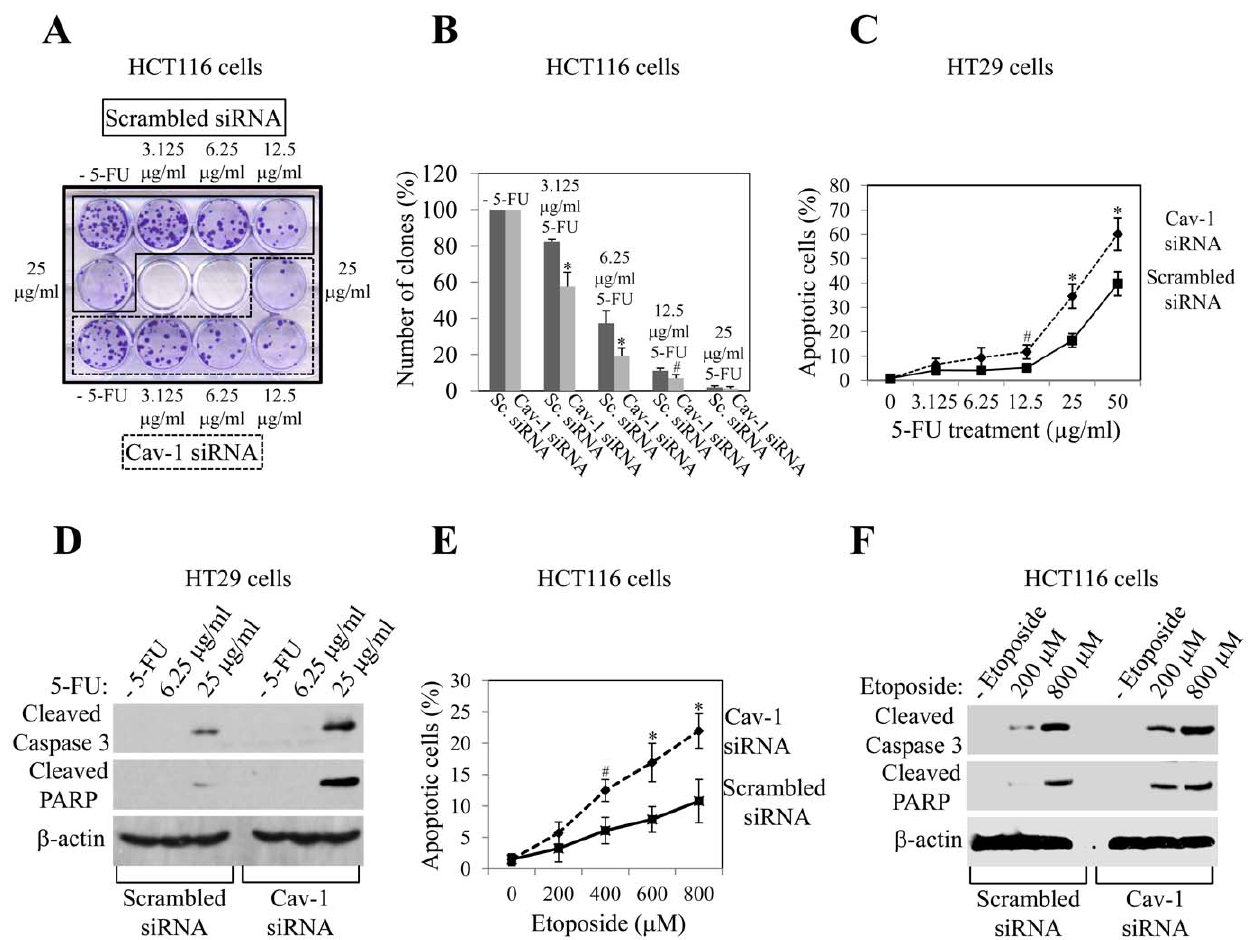
Figure 2. Caveolin-1 promotes long-term survival and inhibits apoptosis of colon cancer cells after treatment with chemotherapeutic drugs. HCT116 (A, B, E and F) and HT29 (C and D) colon cancer cells were transfected with siRNA directed against caveolin-1. Transfection with scrambled siRNA was used as control. One day after transfection, cells were treated with different concentrations of 5-FU for 48 h (A–D) or etoposide for 24 h (E and F). Untreated cells were used as control. In (A and B), cells were cultured for 7 days and stained with crystal violet. A crystal violet staining that is representative of three independent experiments is shown in (A), quantification of the number of clones after crystal violet staining is shown in (B). Values represent mean 6 SEM; * P , 0.001; # P , 0.005. In (C and E), cells were stained with DAPI and the number of cells showing nuclear condensation was quantified. Values represent mean 6 SEM; * P , 0.001; # P , 0.005. In (D and F), cells were subjected to immunoblotting analysis with antibody probes specific for cleaved caspase 3 and PARP. Immunoblotting with anti- b -actin IgGs was done to show equal loading.